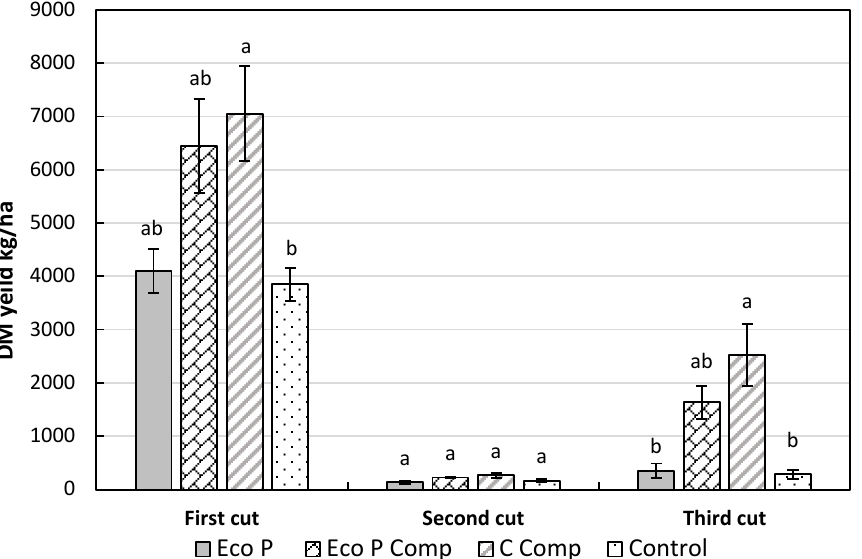
Figure 2. First-year effect of fertiliser treatment on grass DM yield over the first year (2018) grass harvest; within each harvest, shared letters denote that no statistically significant difference occurred ( p > 0.05); error bars indicate standard error.